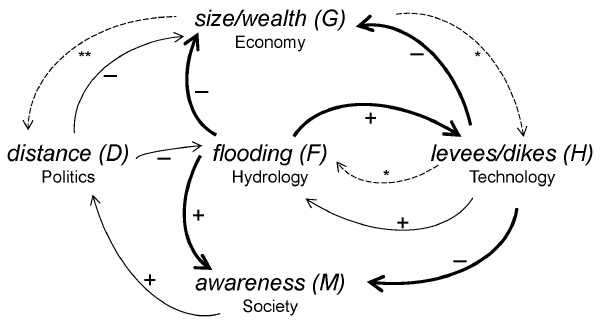
Fig. 3. Loop diagram showing how hydrological, economical, polit- ical, technological, and social processes are all interlinked and grad- ually (continuous thin arrows) co-evolve, while being abruptly (con- tinuous thick arrows) altered by the sudden occurrence of flooding events. Dashed arrows indicate control mechanisms: ∗ conditions in Eqs. (1) and (2); ∗∗ ability to move in Eq.